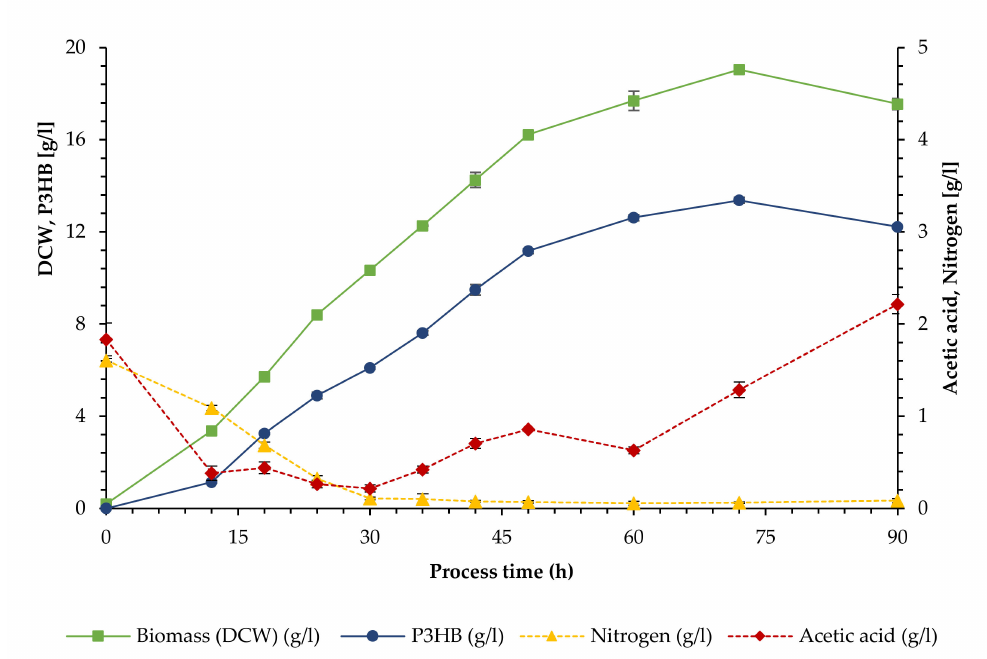
Figure 2. Cultivation of Bacillus megaterium uyuni S29 in a cell recycle process (I). Biomass (as DCW) and polymer (P3HB) concentration (left axis) and concentration of acetic acid and nitrogen (as TKN) (right axis). Error bars represent standard deviation from triplicate samples.